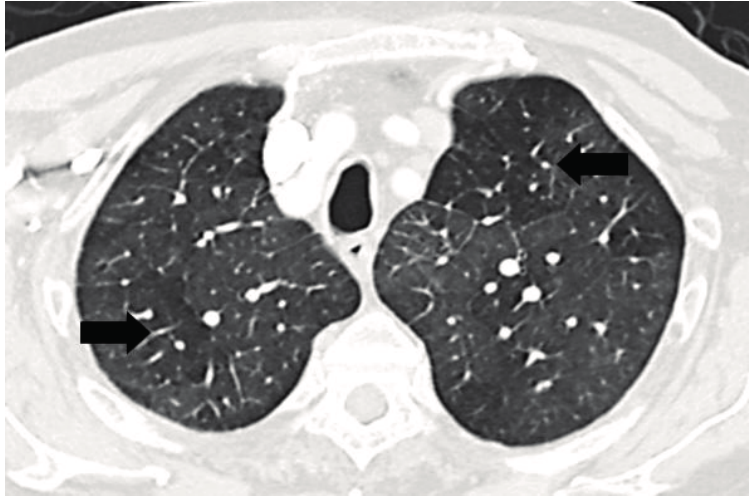
Figure 1. Chest computed tomographic (CT) scan demonstrates mosaic pattern of lung attenuation where there is a patchwork of regions of differing attenuation with well-defined borders (black